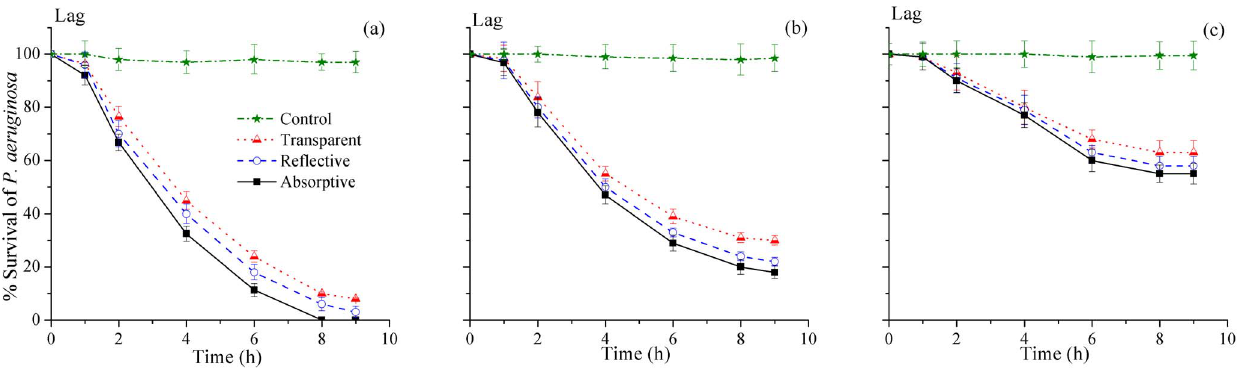
Figure 4. P.aeruginosa inactivation with different rear surfaces of PET bottles under (a) sunny, (b) mild, and (c) weak weather